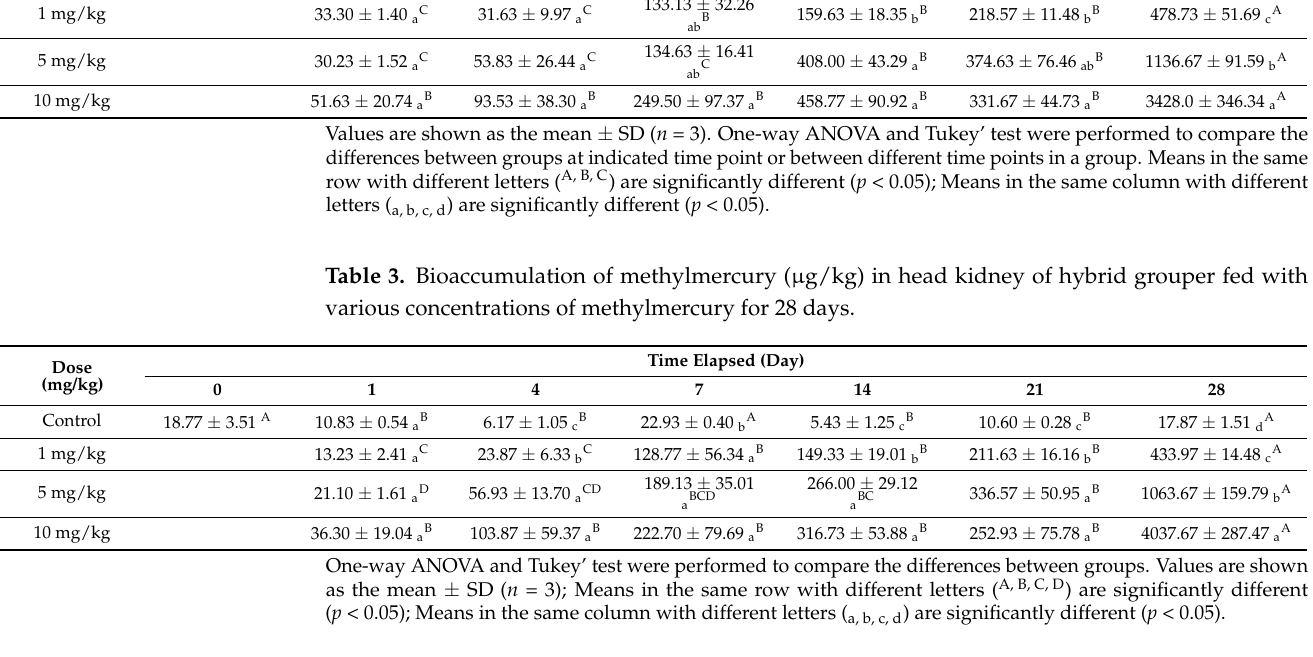
Table 4. Bioaccumulation of methylmercury ( µ g/kg) in muscles, liver and kidney of hybrid grouper fed with various concentrations of methylmercury for 28